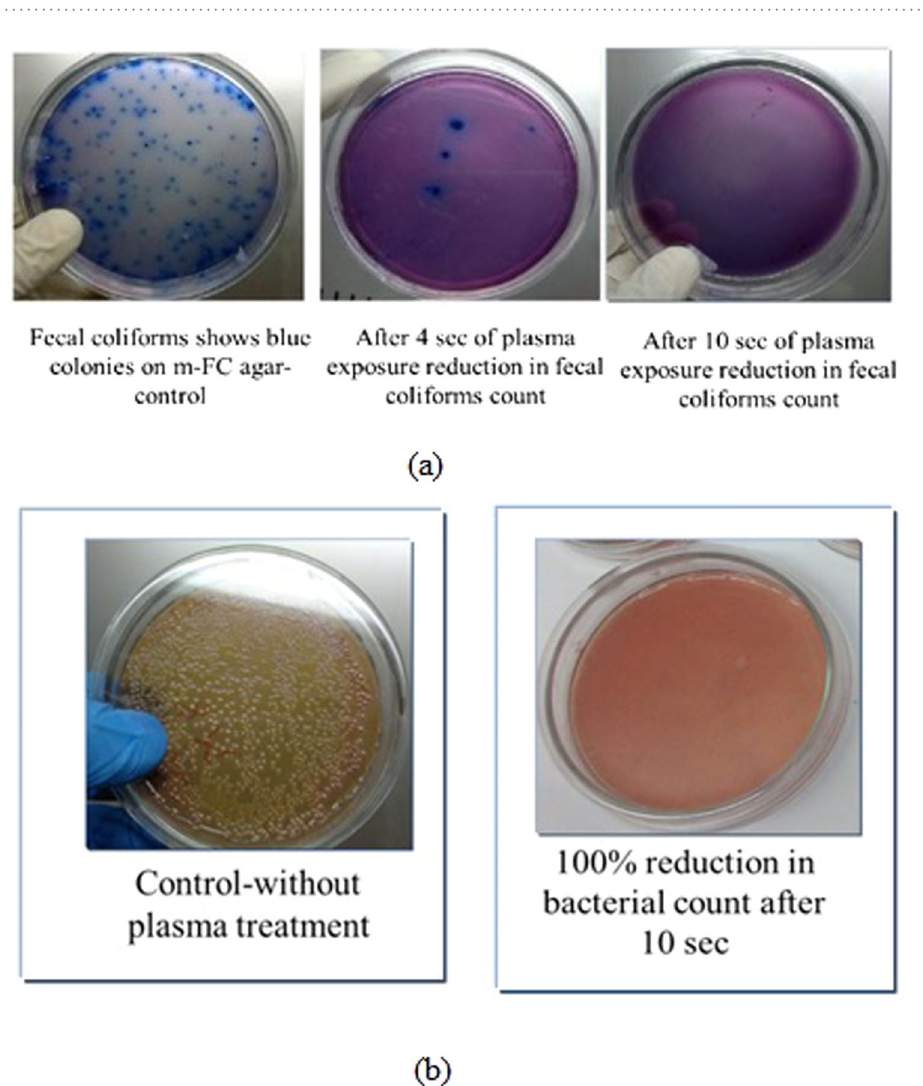
Figure 6. The colony reduction of ( a ) Fecal coliform and ( b ) Shigella boydii on agar